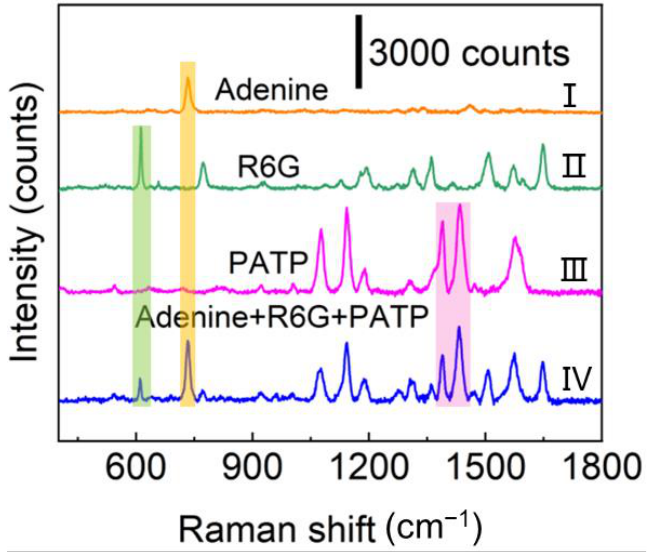
Figure 4. Raman spectra of (I) 10 − 4 M adenine, (II) 10 − 6 M R6G, (III) 10 − 4 M PATP, and (IV) the mixed ternary analytes containing 10 − 6 M R6G, 10 − 4 M adenine and 10 − 4 M PATP.